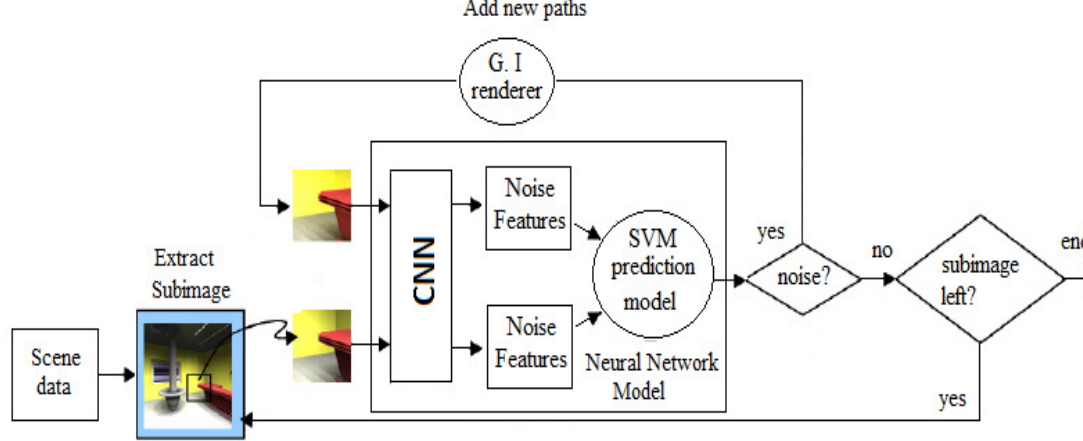
Figure 6. A schematic representation of the Path Tracing progressive algorithm including noise detection for each sub-image. At each iteration, new paths are added to the un-converged sub-images. Then, the model is tested if each new sampled sub-image is still noisy or not. According to the models answer, we decide then to add new paths or to stop computation for the corresponding sub-image as it is supposed to be visually